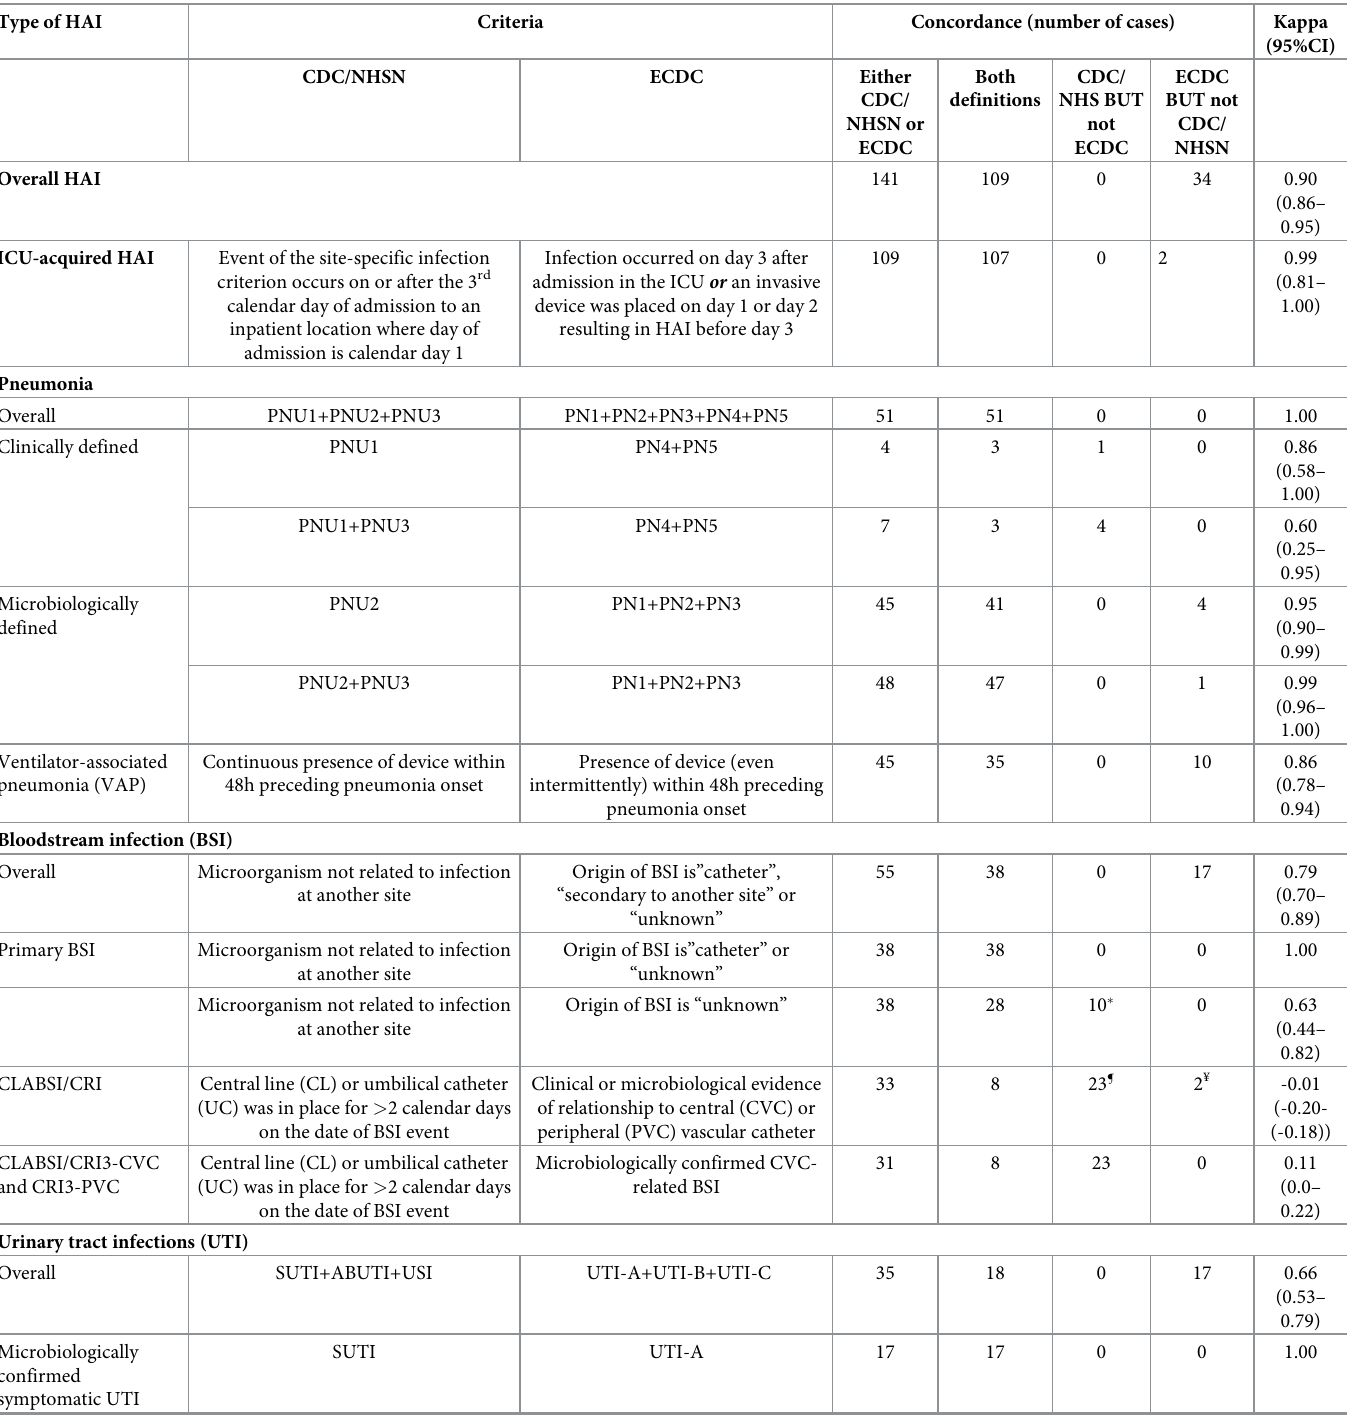
Table 3. Agreement between HAI